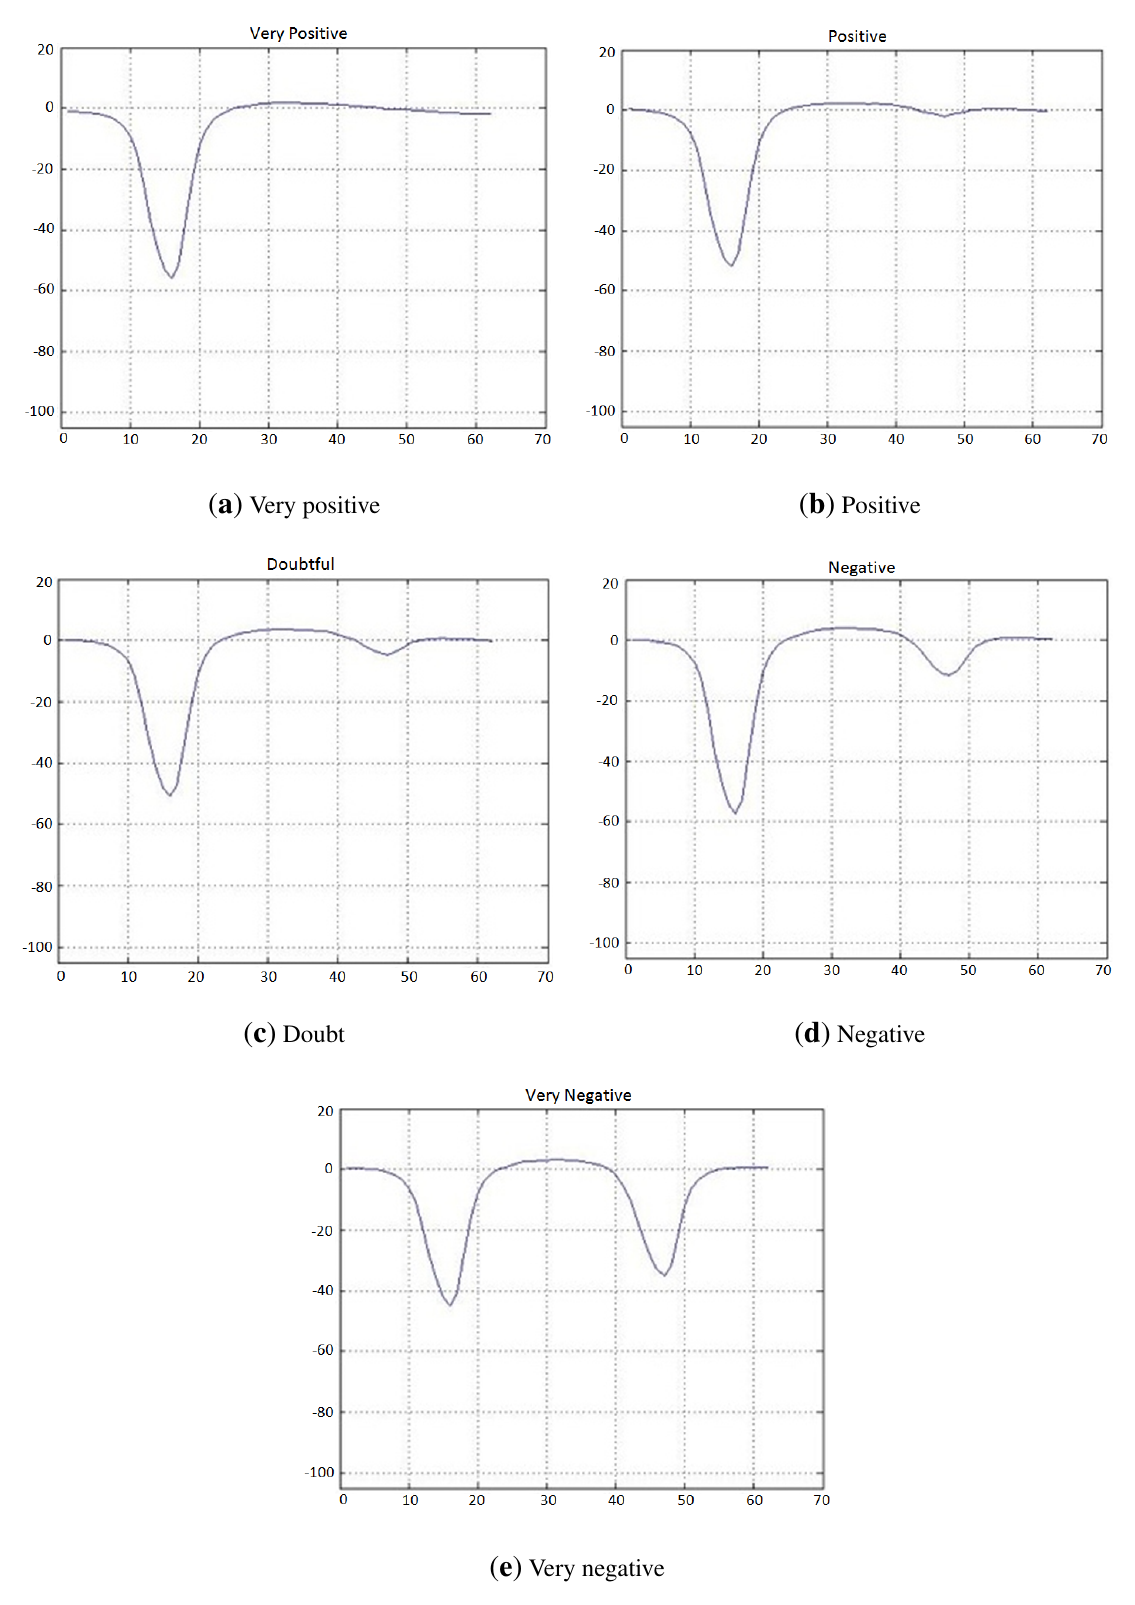
Figure 11. Lateral histograms representing a prototype of each labeled class used for the classifier for test lines in non-alcohol